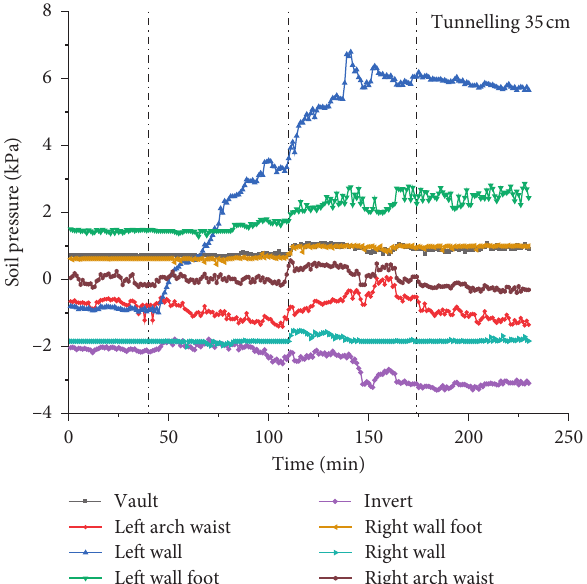
Figure 14: Time-history curve of earth pressure around the mining tunnel.